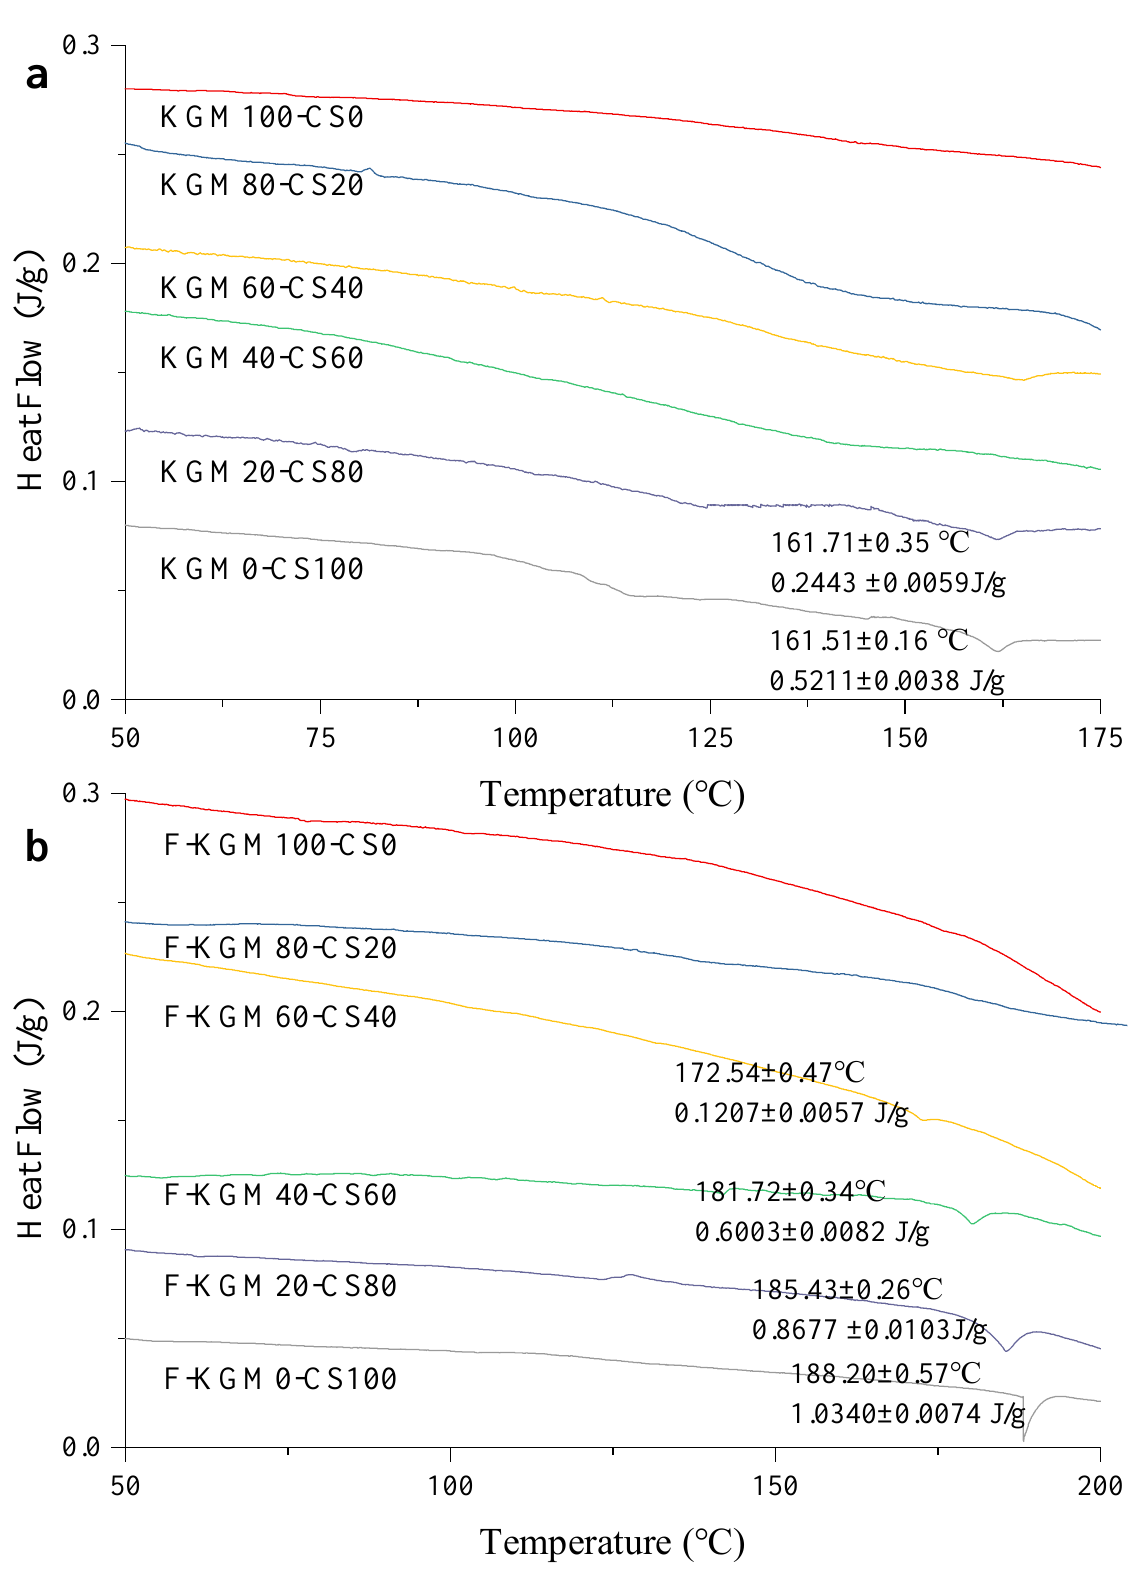
Figure 3. Retrogradation of starch in the composite gels: ( a ) KGM–CS gels; ( b ) F–KGM–CS gels.